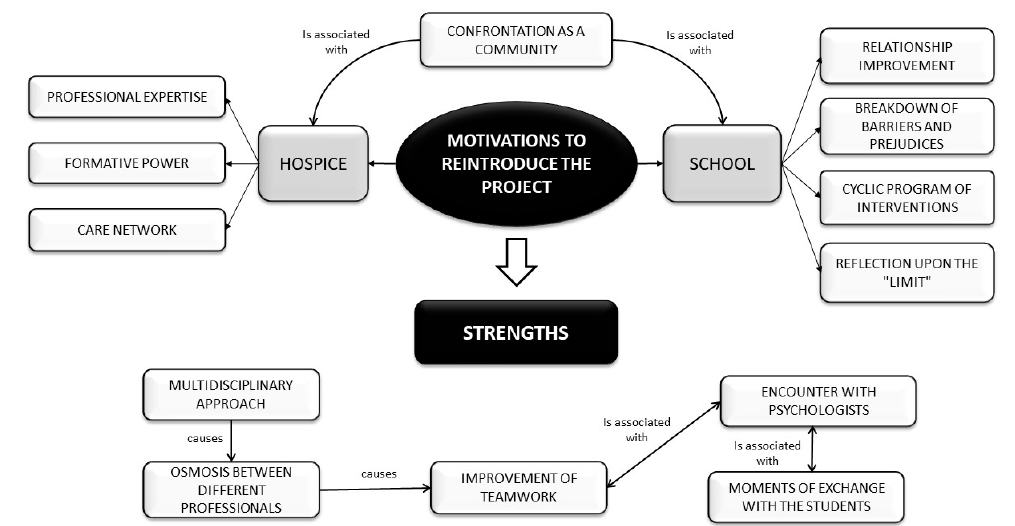
Figure 3. Motivation to reintroduce the project.